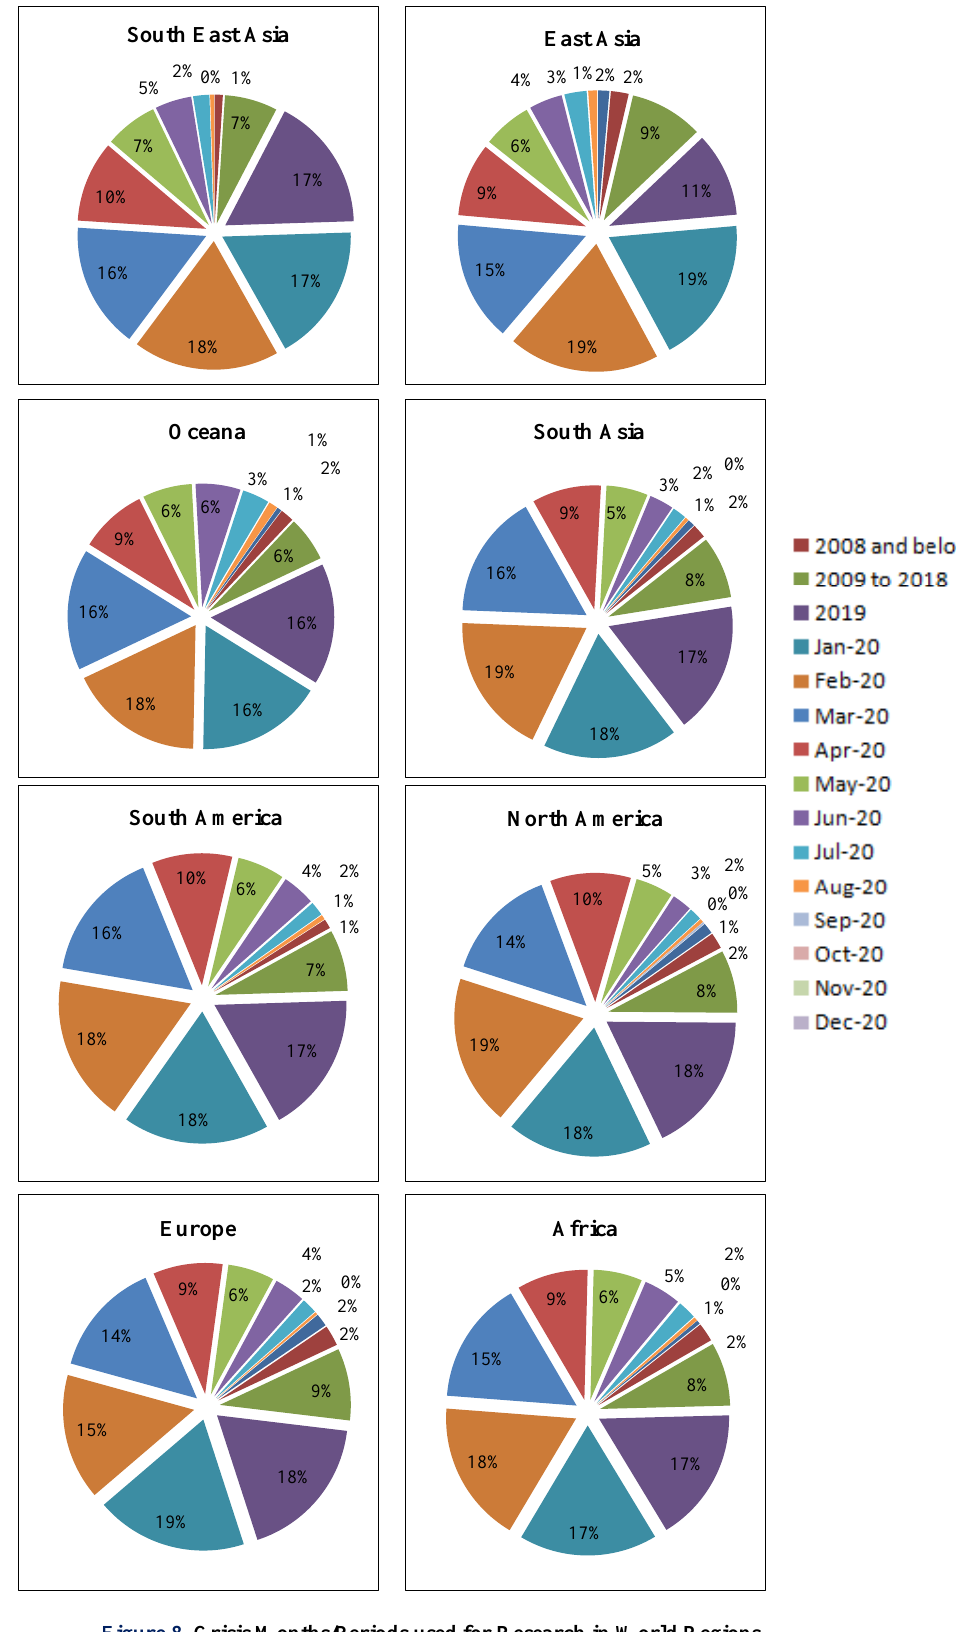
Figure 8. Crisis Months/Periods used for Research in World